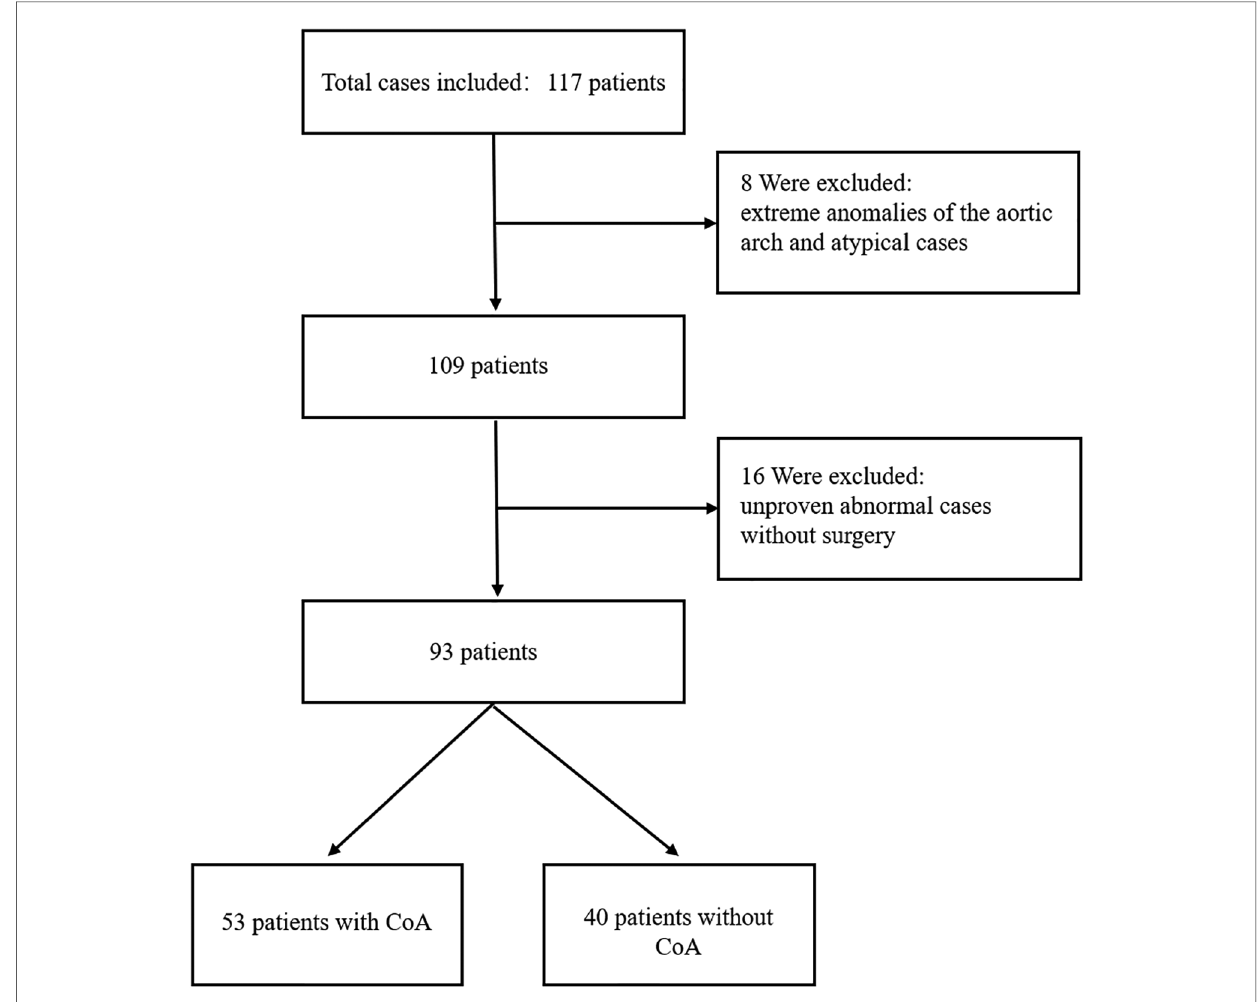
FIGURE 1 The fl ow chart of study population